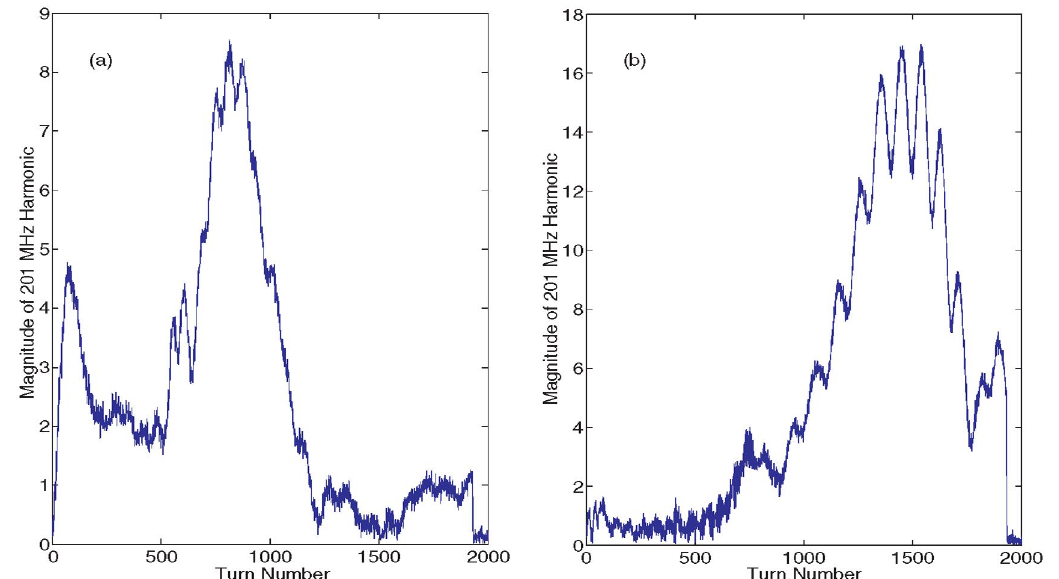
FIG. 3. (Color) (a) Evolution of the 72nd harmonic corresponding to the 201.25 MHz linac microbunch frequency during injection and storage for the chopped beam experiment shown in Fig. 1. (b) The same as (a) but for the unchopped beam experiment shown in Fig.